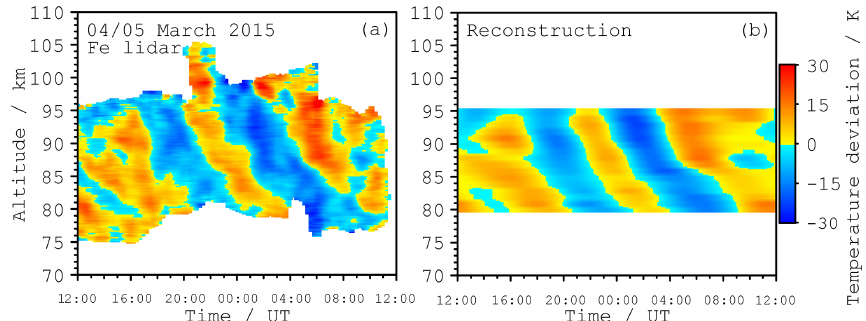
Figure 7. Temperature observations with the Fe lidar (a) and the reconstruction using the four harmonic components (b) derived in the